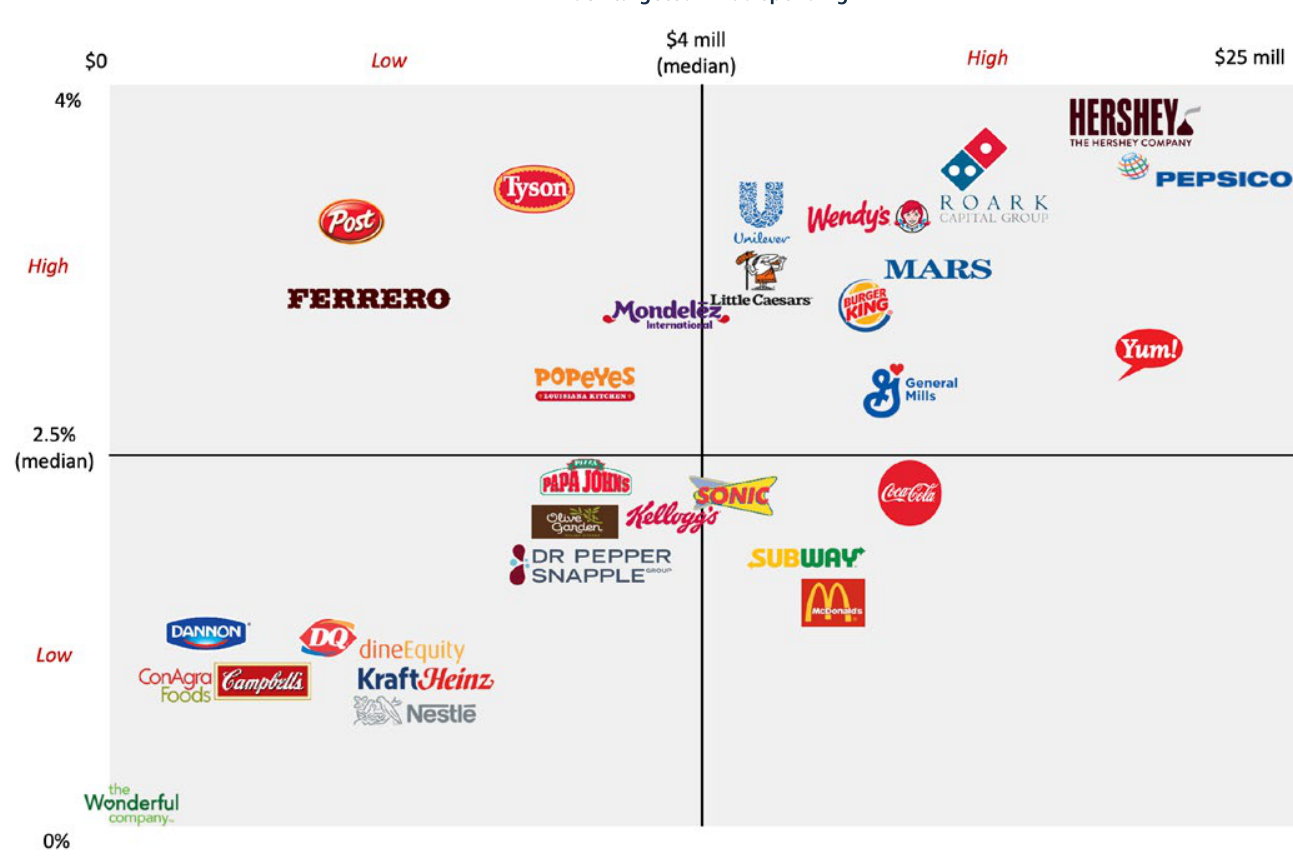
FIGURE 6. COMPANY INVESTMENTS IN BLACK-TARGETED